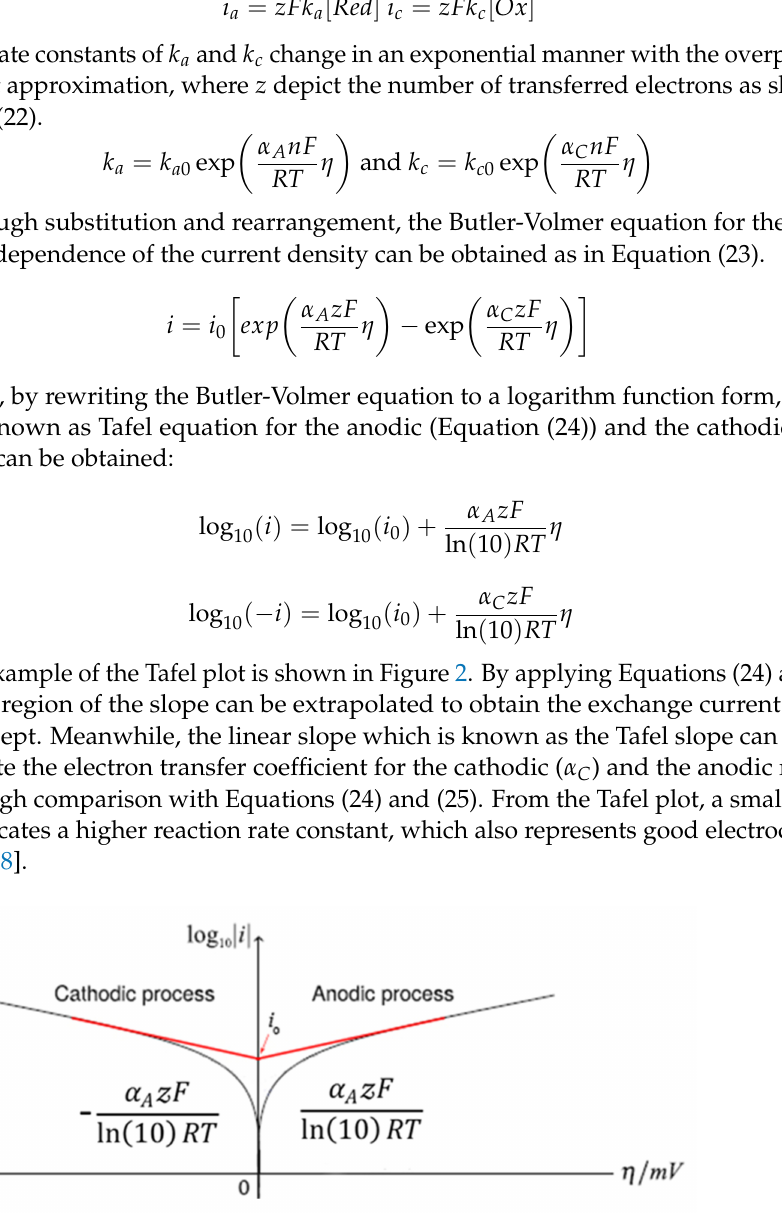
Figure 2. Example of Tafel plot showing a cathodic process in the left side and anodic process on the right